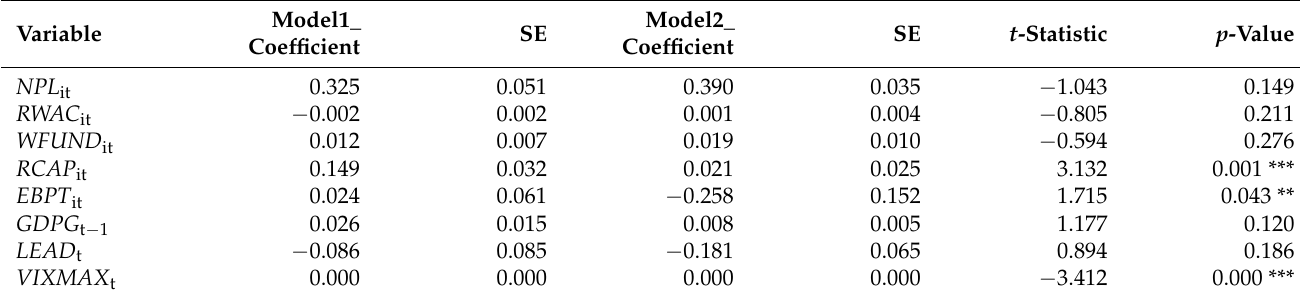
Table A18. Comparison of crisis (adjusted) (4) and post-crisis (adjusted)